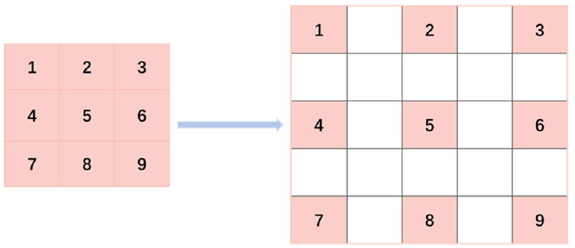
Figure 3. Difference between convolution kernels of dilated convolution and standard convolution.